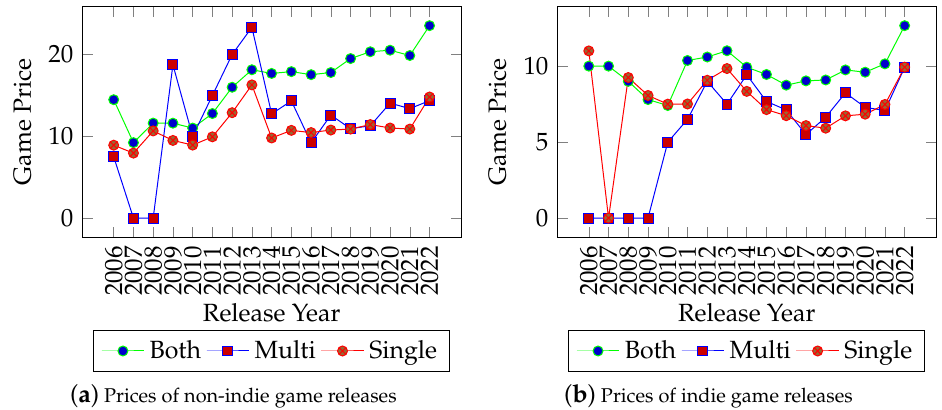
Figure 9. Prices of game types released over the year for ( a ) non-indie games and ( b ) indie games.